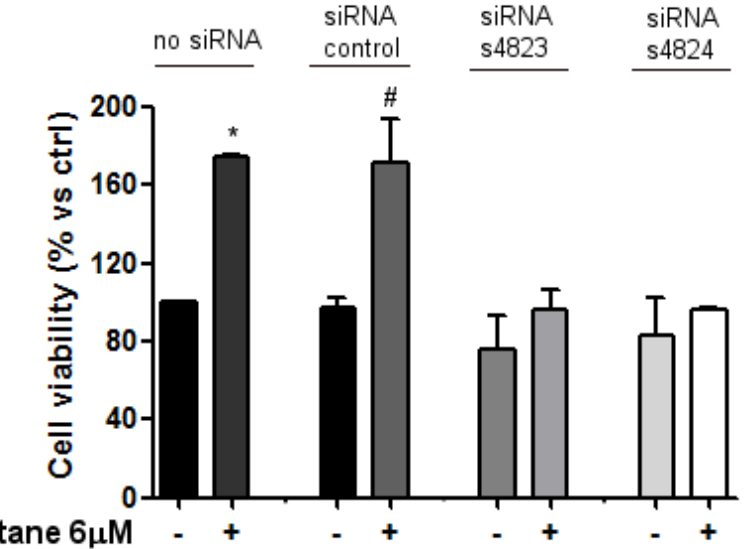
Figure 5. Effect of ER-α silencing on mitotane activity in MCF-7 cell line. Untreated cells, siRNA scramble, and siRNA s4823/s4824-treated MCF-7 cells were exposed to mitotane 6 µM for three days. Cell viability was measured by MTT assay. Results are expressed as percentage of viable cells ± SEM vs. ctrl. Data are the mean of three different experiments, with each point running in triplicate. * p < 0.01 vs. untreated cells (ctrl); # p < 0.01 vs. siRNA scramble-treated cells.